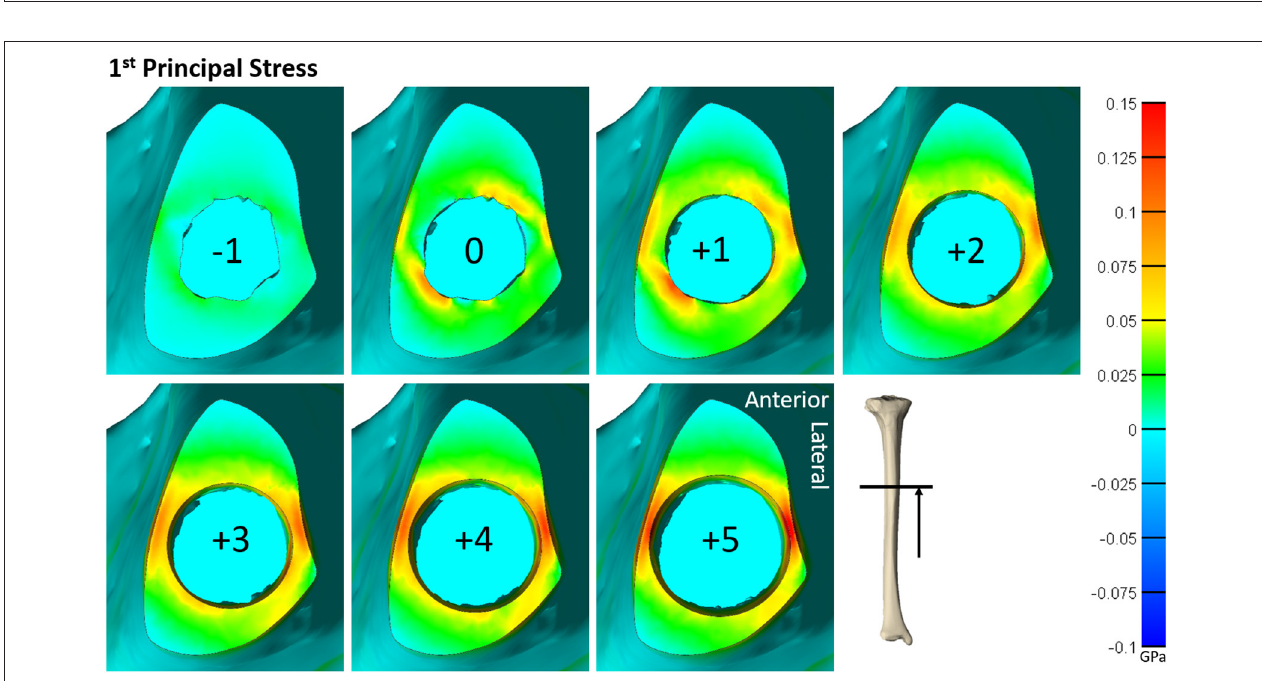
FIGURE 5 | Heat map of the first principal stress (circumferential stress) for each size of implanted endoprosthesis for one of the tibia models. For small endoprosthesis sizes, maximum stress occurred around subject-specific morphologic features. Once the endoprosthesis made contact with more areas of the bone (around size 3), peak stress was uniformly distributed around the medial and lateral regions, and began to propagate through the thickness of the bone at the distal end.